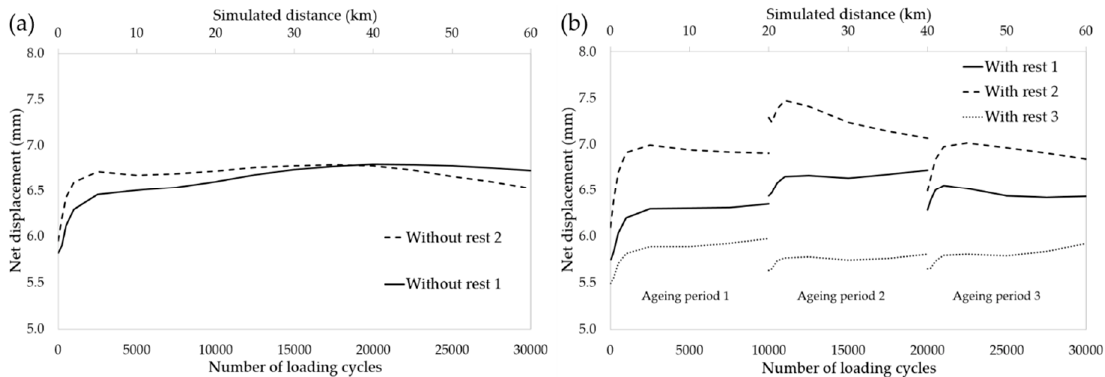
Figure 4. Net displacement vs. number of loading cycles, ( a ) without rest periods and ( b ) with rest